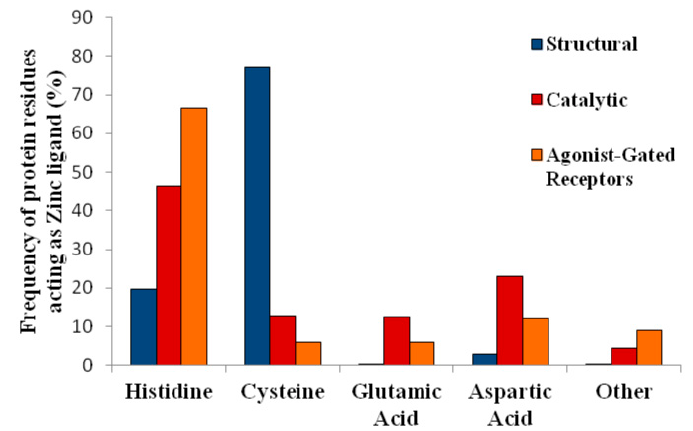
Figure 2. Distribution of amino acids acting as Zn(II) ligands in structural proteins, enzymes, and agonist-gated receptors. The frequency of zinc ligand amino acids was analyzed in 10,931 sites of 4882 proteins with structural or catalytic activity. The results are expressed separately for each protein regardless of its functions. The data for the structural and catalytic sites in proteins was extracted from Andreini et al. [5], while the data for 14 agonist-gated receptors is further summarized in Table 1. Currently, only one crystalline structure is available for a receptor-gated channel with its allosteric modulator zinc [20].